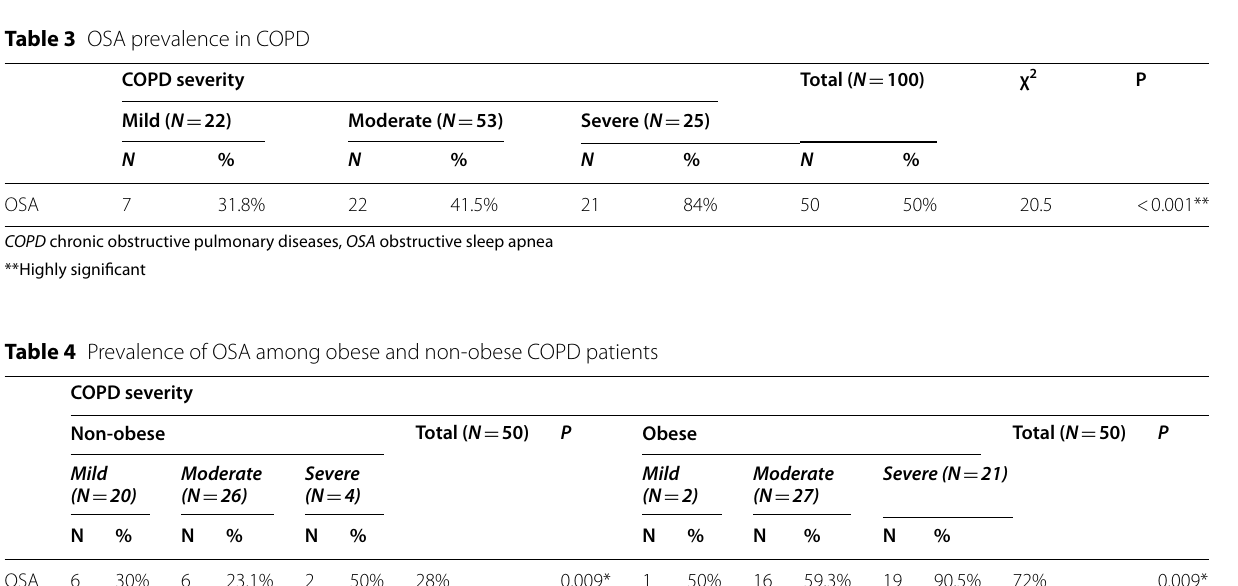
COPD chronic obstructive pulmonary diseases, OSA obstructive sleep apnea *Significant